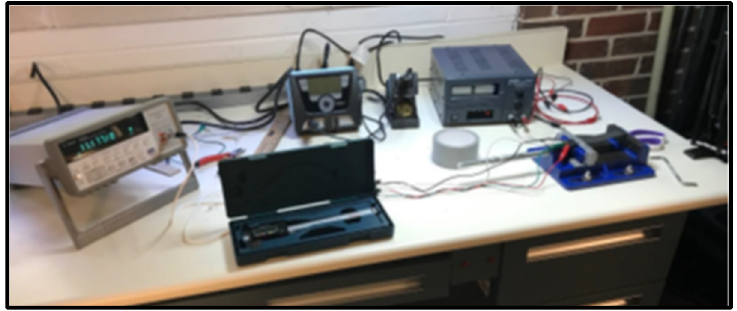
Figure 3. Micro-ohm meter testing setup (Iteration I).